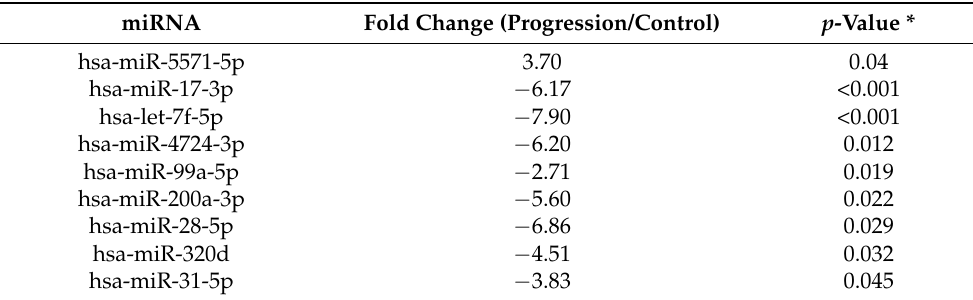
Table 2. List of differentially expressed miRNAs between the progression and control groups on microarray analyses.